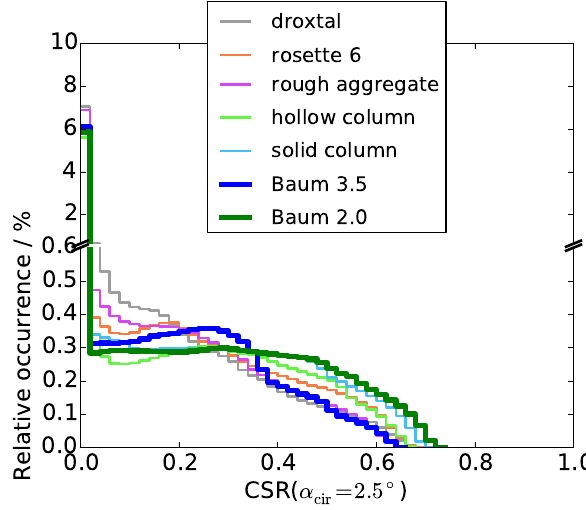
Fig. 3. Uncertainty in circumsolar irradiance for certain fields of view (legend gives opening half angle in degrees). Solid lines: for r eff = 25 µ m and undefined ice particle shape. Dashed lines: for un- defined r eff and ice particle shape.